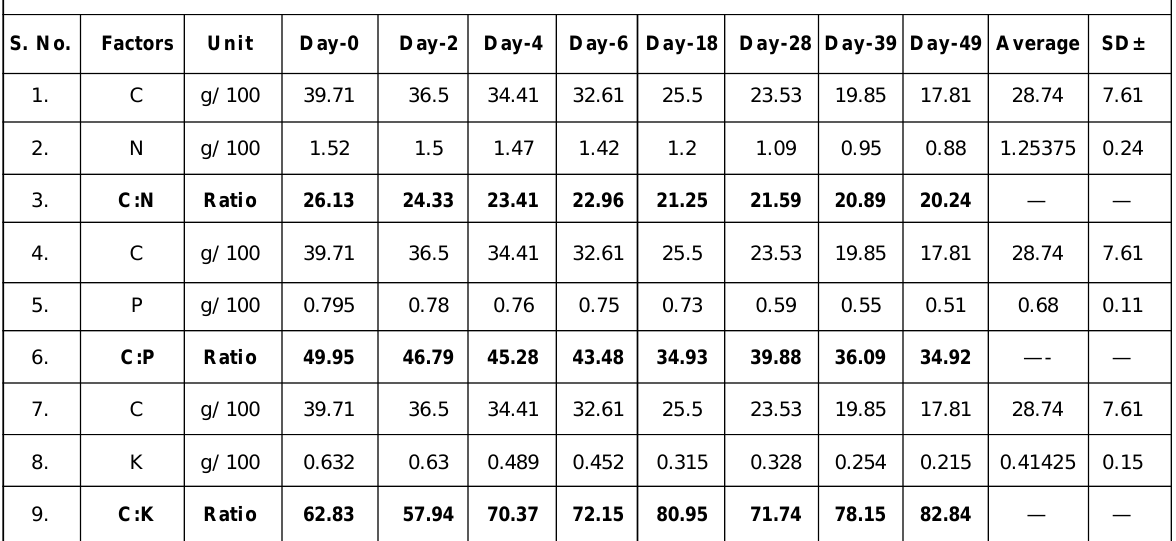
Table 2: The analysis results C:N, C:P and C:K ratio in white button mushroom